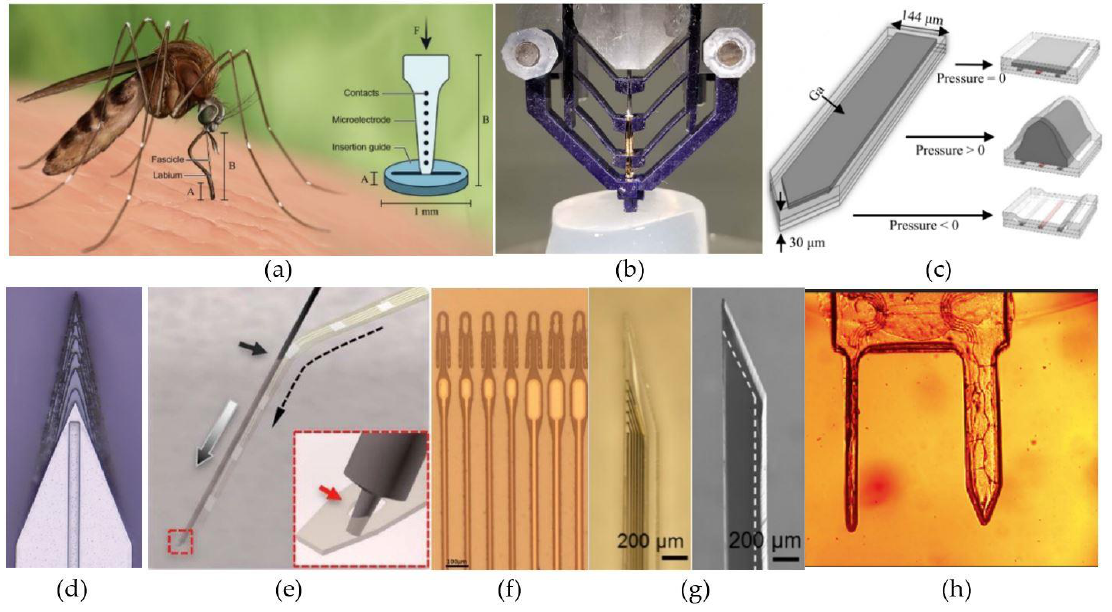
Figure 6. Methods to aid the implantation of flexible intracortical probes. ( a ) An external PMMA guide based on a mosquito’s labium. Reproduced with permission from [185]; published by Nature, 2018. ( b ) A microelectrode guide constructed out of four pairs of separated arms with a central opening through which the probe can pass. Reproduced with permission from [186]; published by IEEE, 2019. ( c ) A PDMS probe with an integrated microfluidic channel filled with gallium. Reproduced with permission from [187]; published by Elsevier, 2019. ( d ) A 3D-sharpened insertion shuttle with central wicking channel through which the dissolvable glue can flow and attach the shuttle to the probe. Reproduced with permission from [188]; published by IOP, 2019. ( e ) The principle behind the ‘needle-and-thread’ method. Reproduced with permission from [74]; published by AAAS, 2017. ( f ) Electrode array with integrated loops. Reproduced with permission from [189]; published by BioRxiv, 2019. ( g ) A phase contrast ( left ) and SEM ( right ) image from a parylene probe within a bilayered PVA/PLGA bioresorbable shuttle. The white dashed lines indicate the outer boundary of the parylene probe. Reproduced with permission from [97]; published by IOP, 2018. ( h ) A CMC dissolvable dual-shank needle. Reprinted with permission from ref. [73]. Copyright 2016 Springer Nature.